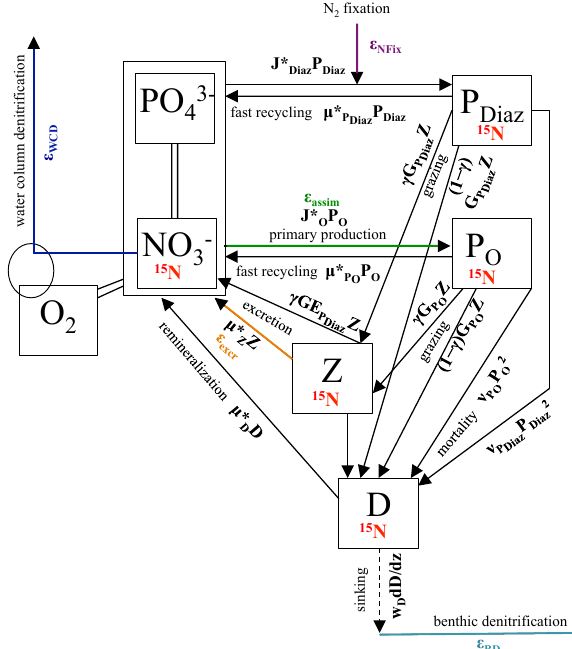
Fig. 1. Schematic of the marine ecosystem/biogeochemical model compartments including the nitrogen isotope parameters (colors) (Somes et al., 2010b). The prognostic variables include 2 nutri- ) and phosphate (PO 3 − ) , 2 phytoplankton, N 2 - ents, nitrate (NO − 3 4 fixing diazotrophs (P Diaz ) and other NO − -assimilating phytoplank- 3 ton (P O ) , as well as zooplankton (Z), sinking detritus (D), and dis- solved oxygen (O 2 )